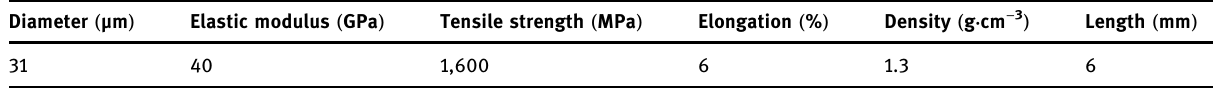
Table 2: PVA fi ber performances Diameter ( μ m